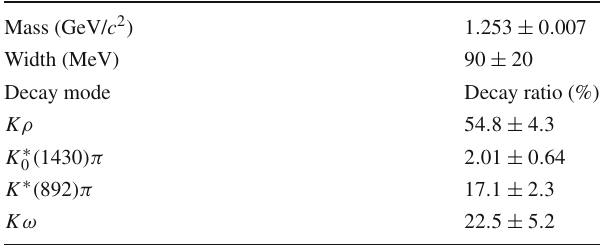
Table 1 Mass, width [26] and ratios of subdecays of K 1 ( 1270 )